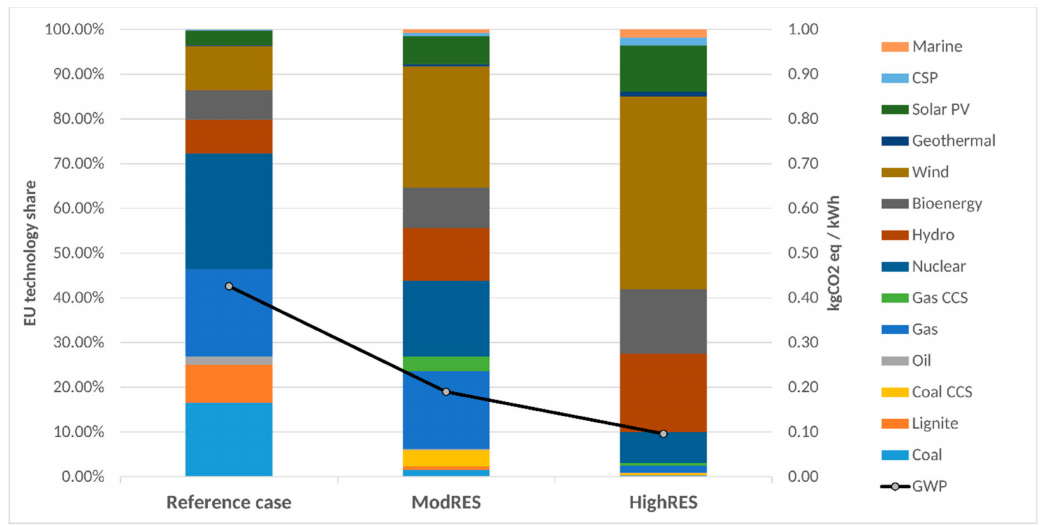
Figure 2. EU electricity mix and relative average grid carbon intensity in reference case, ModRES and HighRES